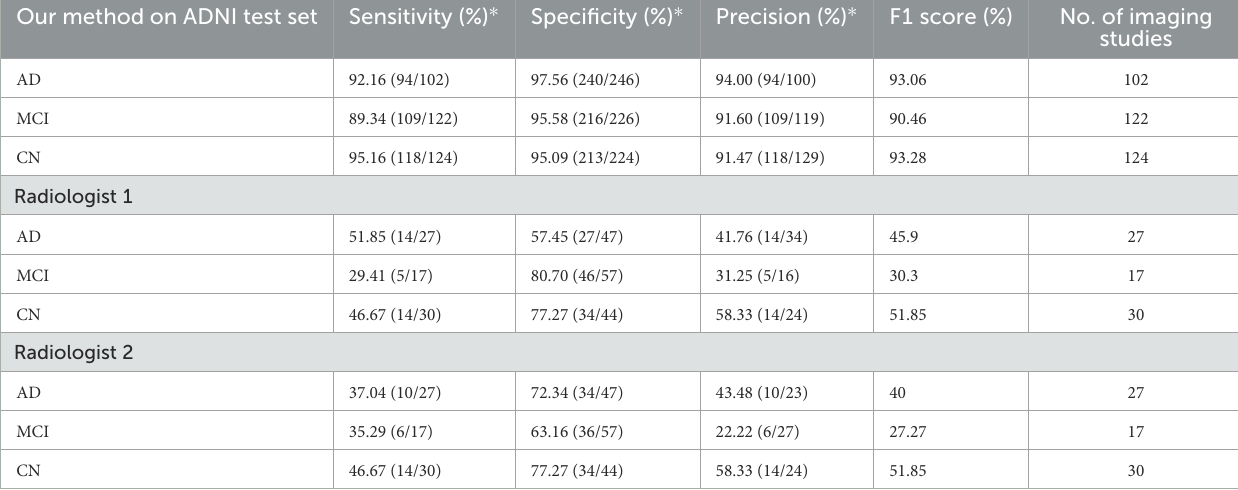
TABLE 2 Comparison of performance between our model and radiology readers in prediction of AD, MCI, and CN.